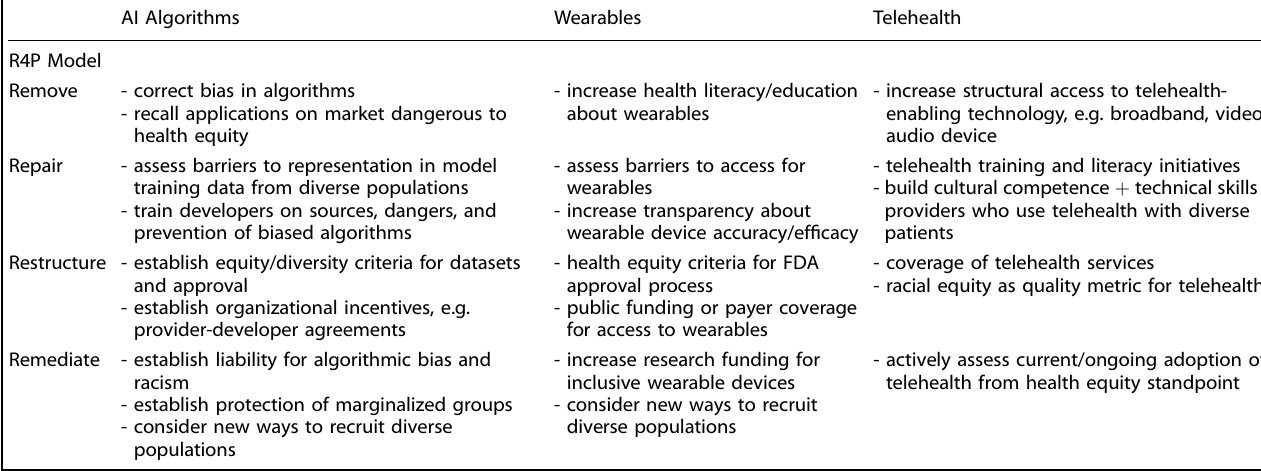
Table 1. R4P Model for Digital Medicine